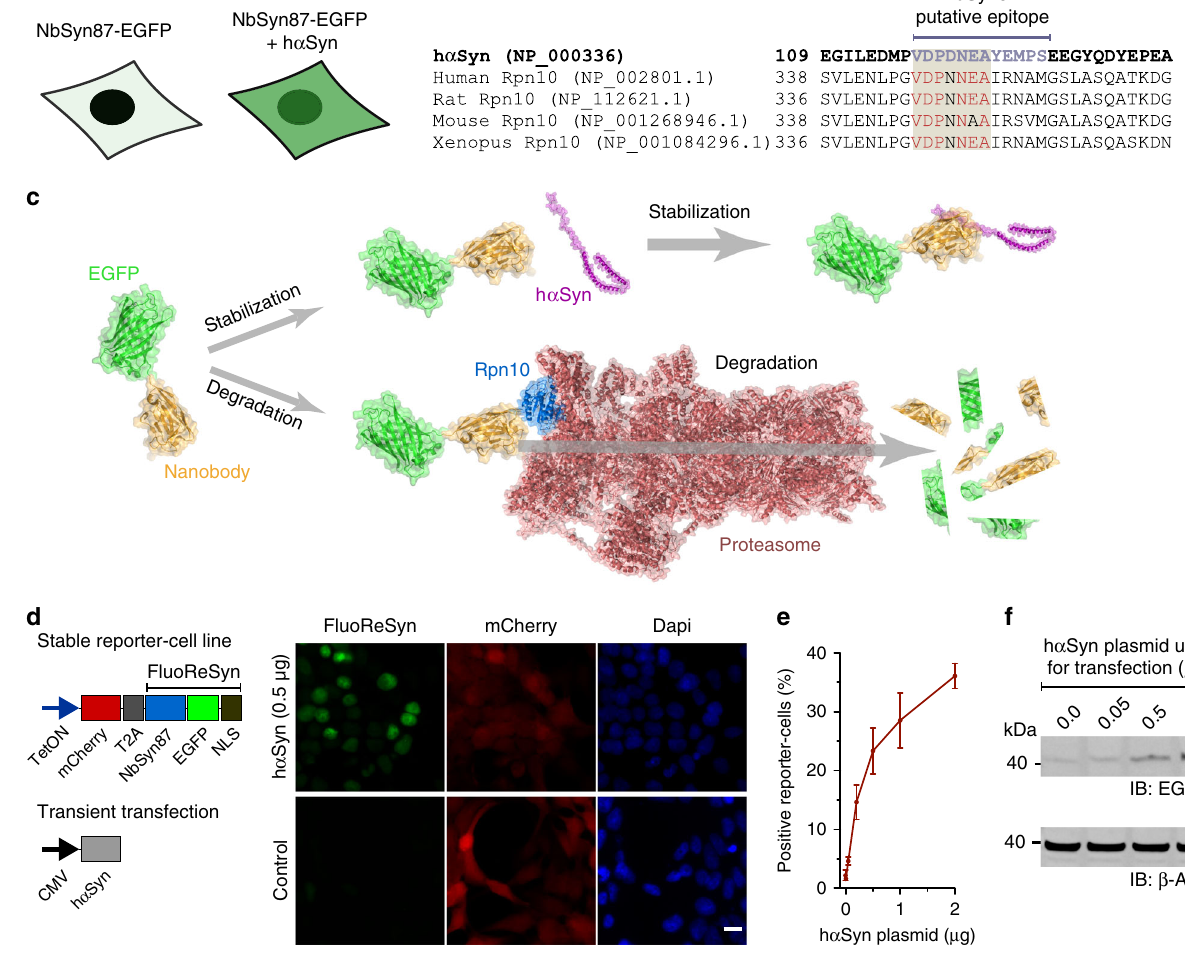
Fig. 1 α Syn-dependent accumulation of FluoReSyn in HEK293 cells. a Schematic representation of the initial observation of cells transiently expressing NbSyn87-EGFP alone (left) or together with h α Syn (right). Although the former group of cells showed minimal fl uorescence, the latter presented with a strong EGFP signal. b Alignment of the amino-acid sequence from h α Syn and Rpn10 across different species. Rpn10 residues similar to h α Syn in the putative epitope are displayed in red. c Schematic representation of the proposed mechanism of degradation versus stabilization of SynNb87-EGFP in the presence or absence of h α Syn. The following Protein Data Bank (PDB) accession numbers were used and modi fi ed to assemble the schematic: 2Y0G (EGFP), 2 × 6 M (Nanobody), 1XQ8 (h α Syn), 6MSK (Proteasome). d Schemes of constructs used to transfect HEK293 cells (left). For the stably transfected cells, a tetracycline-inducible promotor (TetON) was used, followed by a mCherry reporter sequence, a cleavable T2A sequence, and FluoReSyn made of NbSyn87, EGFP and a nuclear localization signal (NLS) sequence. Transient expression of untagged wild-type human h α Syn was driven by a plasmid containing a cytomegalovirus (CMV) promotor. Equally scaled, representative images of doxycycline-induced Reporter-cells (right). Cells were either mock transfected (control) or transiently transfected with the h α Syn expression constructs. Scale bar represents 10 µ m e Quantitative analysis of EGFP-positive cells transfected with variable quantities of h α Syn plasmid. Per replication and condition >1000 cells were analyzed. Error bars represent the SEM from three independent experiments ( n = 3). f Western blot analysis of lysates from Reporter-cells transfected with variable quantities of h α Syn. Immunoblotted (IB) anti-EGFP represents FluoReSyn. Loading control is IB Beta-Actin. Full length blots are displayed in Supplementary Fig. 1d. Source data is available as a Source data fi